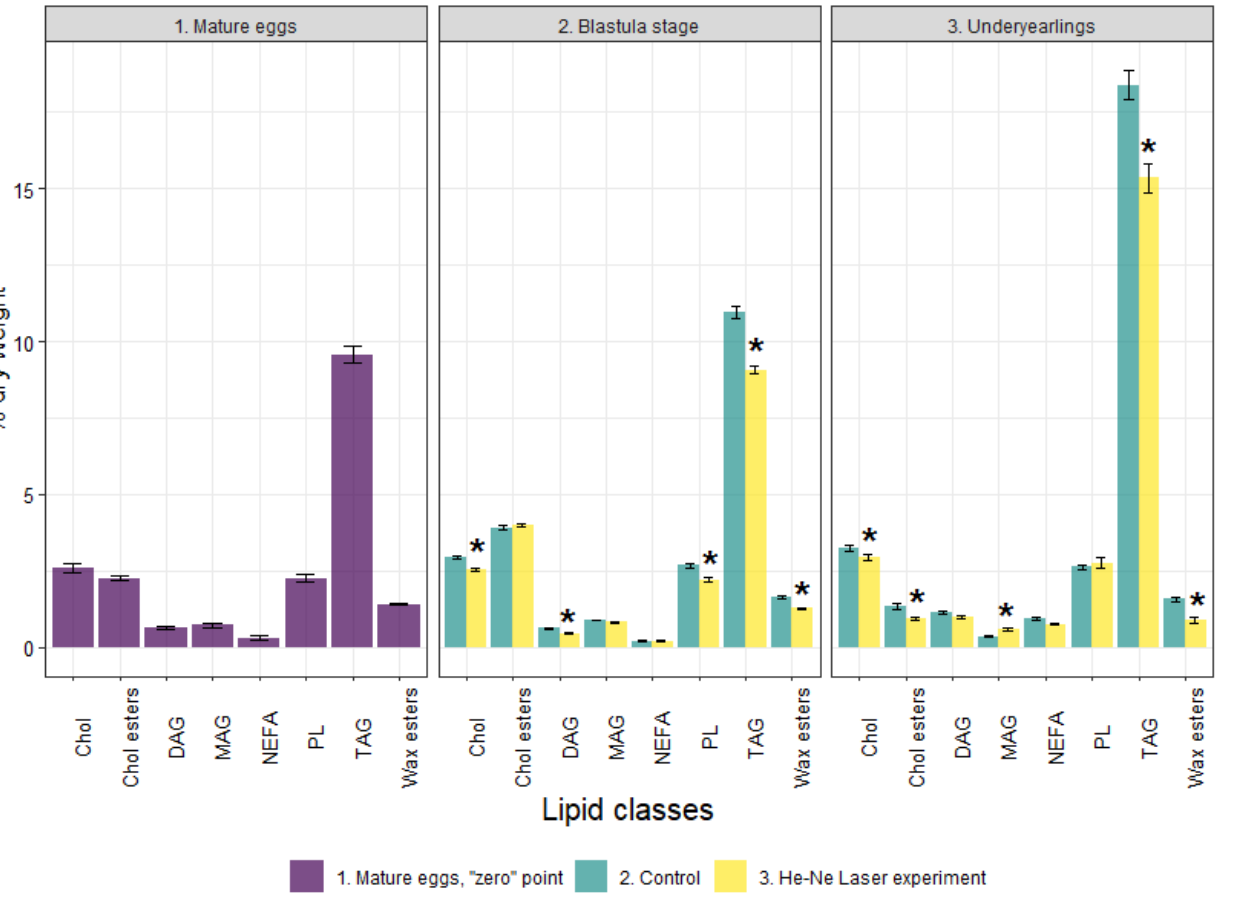
Figure 3. Lipid profile in mature (unfertilized) eggs, at the blastula stage and in underyearlings of Atlantic salmon in control and experiment. *—significantly different ( p < 0.05) between groups.